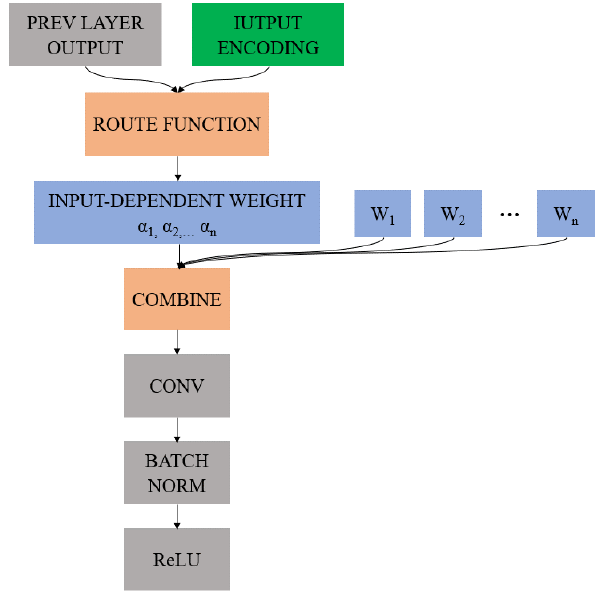
Figure 6. The architecture of CondConv .